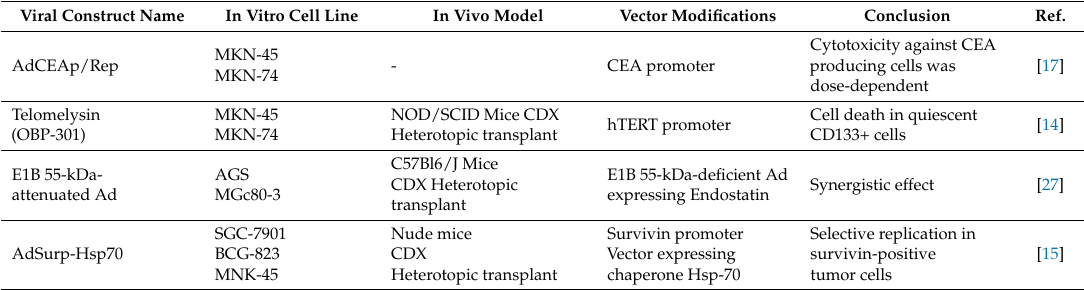
Table 4. Preclinical research in gastric